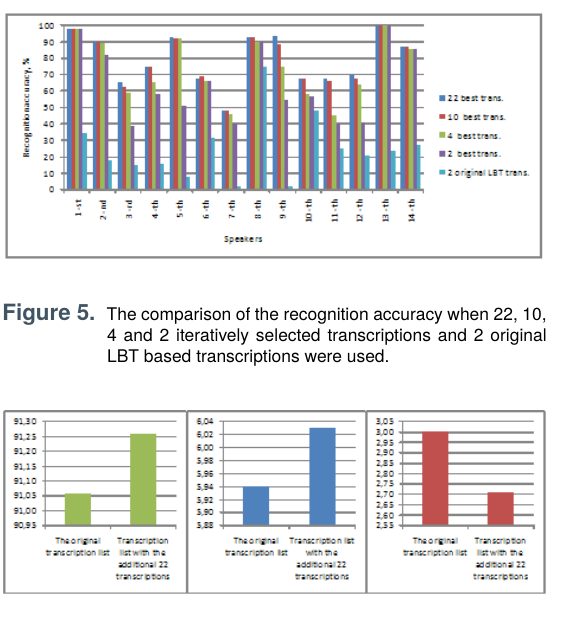
Figure 6. The comparison of the original transcription list and the list with added 22 problematic phrase transcriptions recogni- tion results: a) recognition accuracy, %; b) unrecognized words, %; c) wrongly recognized words, %.